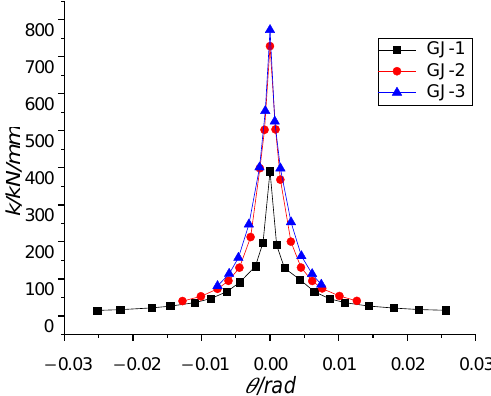
Figure 12. The K − θ curves of three components. Figure 12. The K − curves of three components. The initial stiffness of GJ‑1 is the smallest among the three members, which is about half of that of GJ‑3. The stiffness degradation rates of GJ‑2 and GJ‑3 are roughly the same at the initial stage of loading and both are greater than that of GJ‑1. In the final failure stage, the stiffness of the three members is almost the same, but the corresponding value of the turn angle θ is quite different. It can be concluded that GJ‑1 has much more ductility than GJ‑2 and GJ‑3, and its energy‑dissipating capacity is better than the latter two. The stiffness of GJ‑1 decreases slowly after reaching the peak load‑carrying capacity, which is Figure 12. The K − curves of three components. beneficial for the structure’s absorbance of energy during earthquakes.